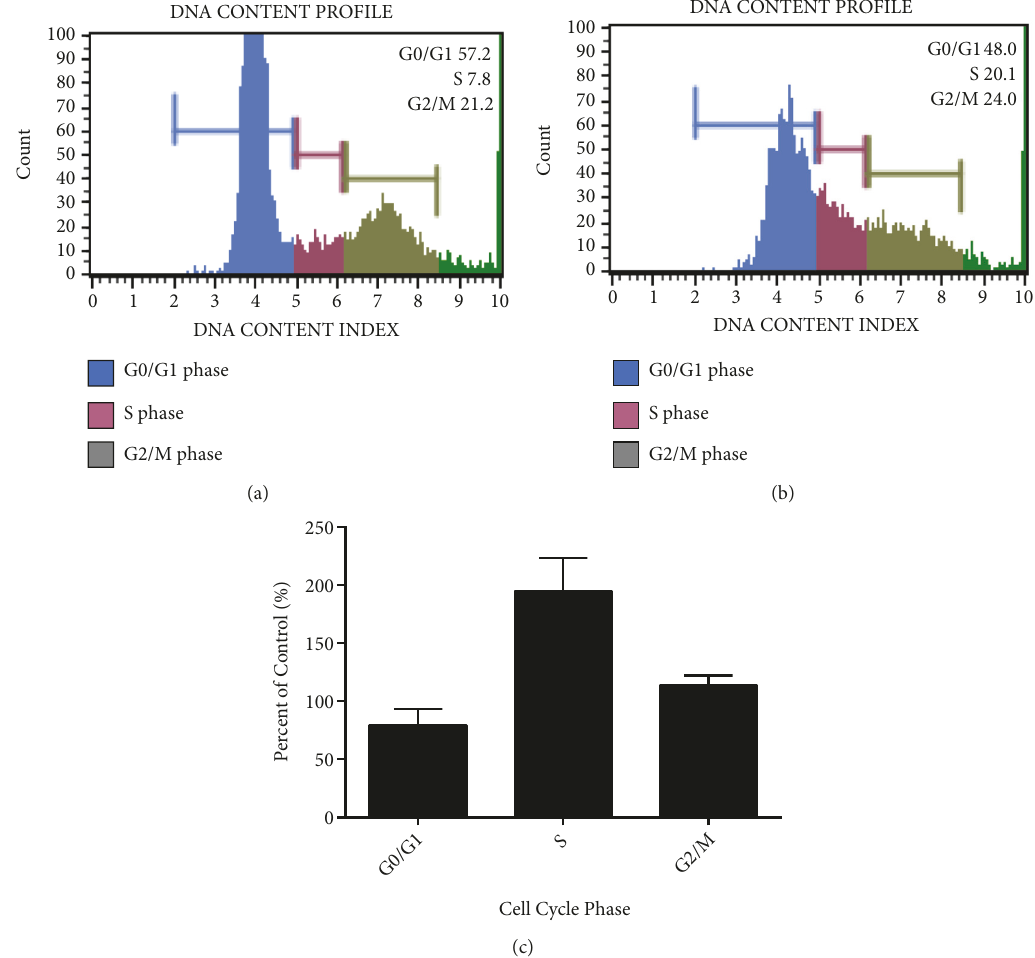
Figure 3: Induction of cell cycle arrest in DU-145 cells by 4,5-diCQA . Cell cycle analysis was performed by setting a threshold for live population based on cell size index and followed by setting gates for the cell cycle based on DNA content. Control group profile (a) was compared to the 4,5-diCQA group treated at the IC 50 concentration (b). Majority (about 50%) of the treated cells were in the G0/G1 phase. (c) The percentage of cells in G0/G1 phase decreased ( p -value = 0.3717), those in the S phase increased ( p -value = 0.0075), and those in G2/M phase did not change significantly ( p -value = 0.1726) compared with the control. Data represented are mean ± SD of four